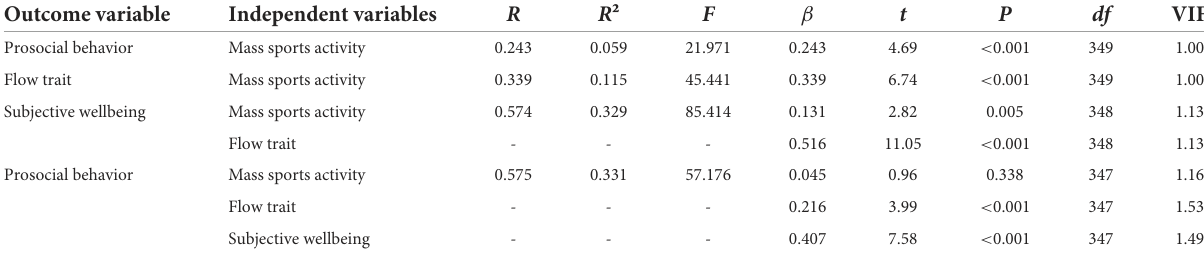
TABLE 3 Results of regression analysis.